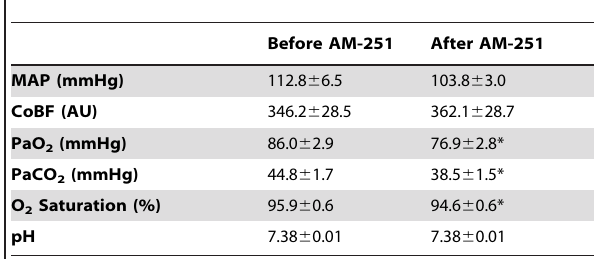
Table 2. Baseline physiological parameters before the administration of AM-404 in the absence and presence of AM-